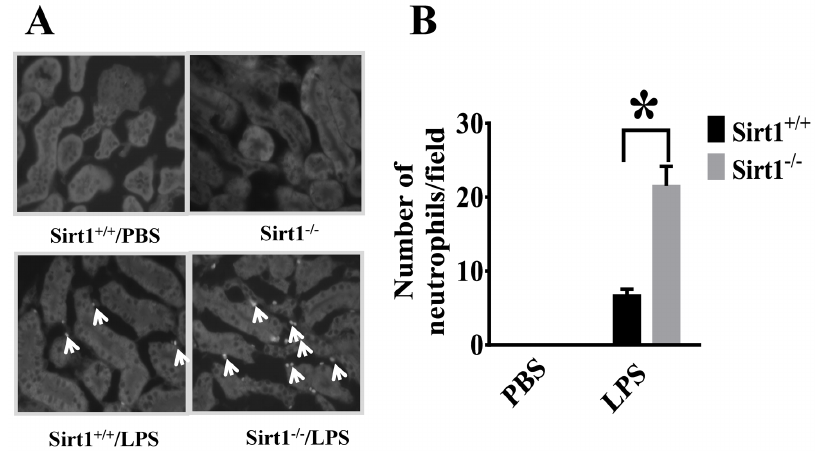
Figure 4. Increased neutrophil infiltration in Sirt1 knockout mice after LPS challenge. Twenty four hours after LPS challenge, kidney tissues from Sirt1 2 / 2 mice and sirt1 + / + littermates were collected (n=5 mice/group). Cryosections were prepared. ( A ) Gr-1 was used as a specific marker for neutrophil staining. Neutrophil (arrow) infiltration was detected. (B) The number of neutrophils was counted. *P , 0.05 versus Sirt1 + / + /LPS